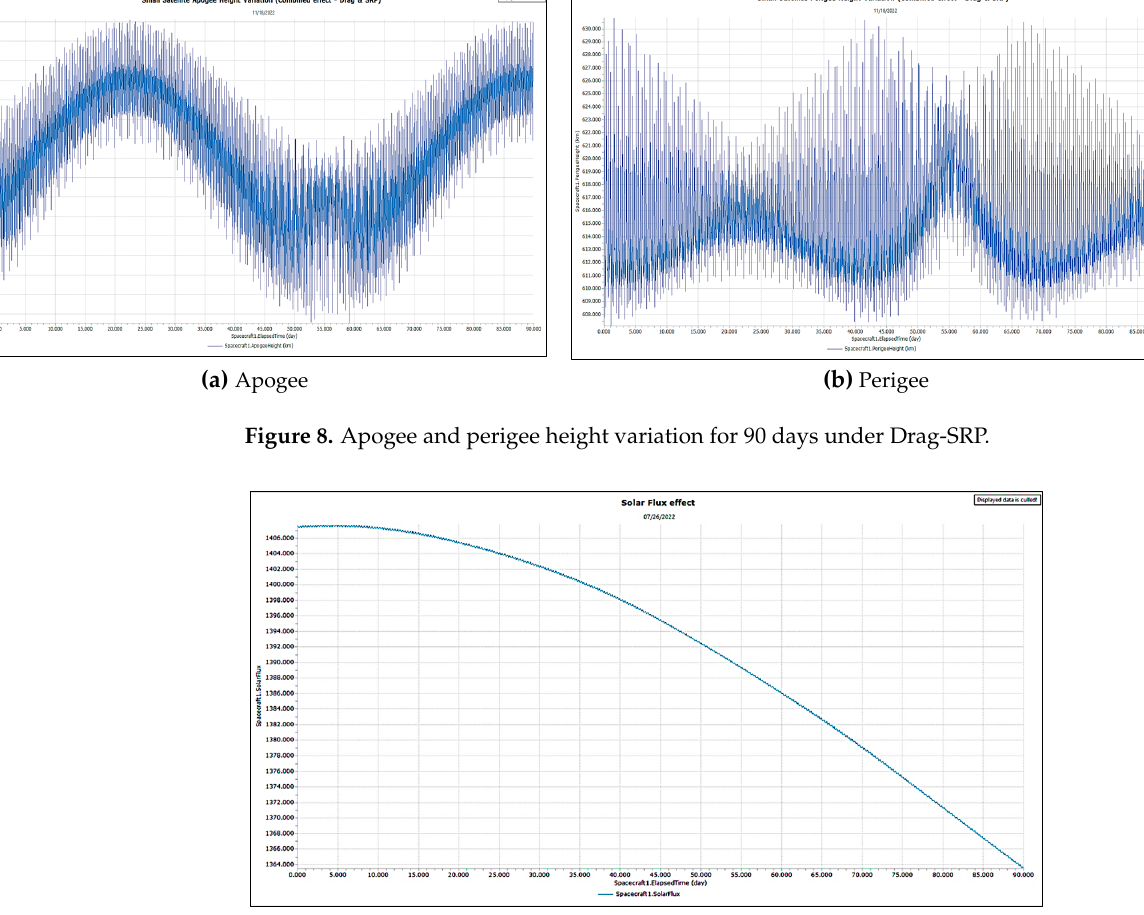
Figure 9. Solar flux effect over the satellite for 90 days.